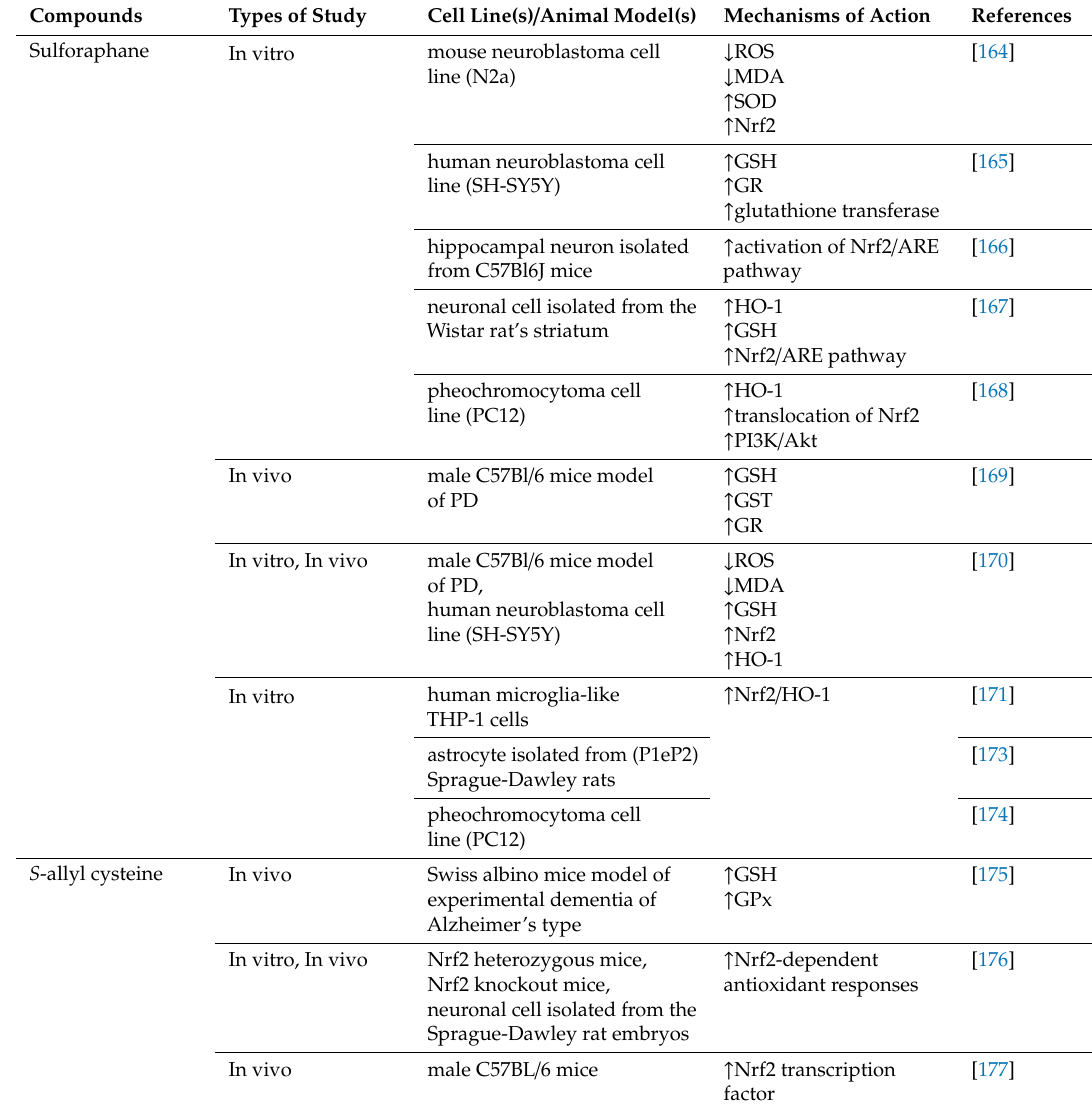
Table 5. Sulfur compounds in combating AD through Nrf2 / Keap1 / ARE and interconnected pathways.